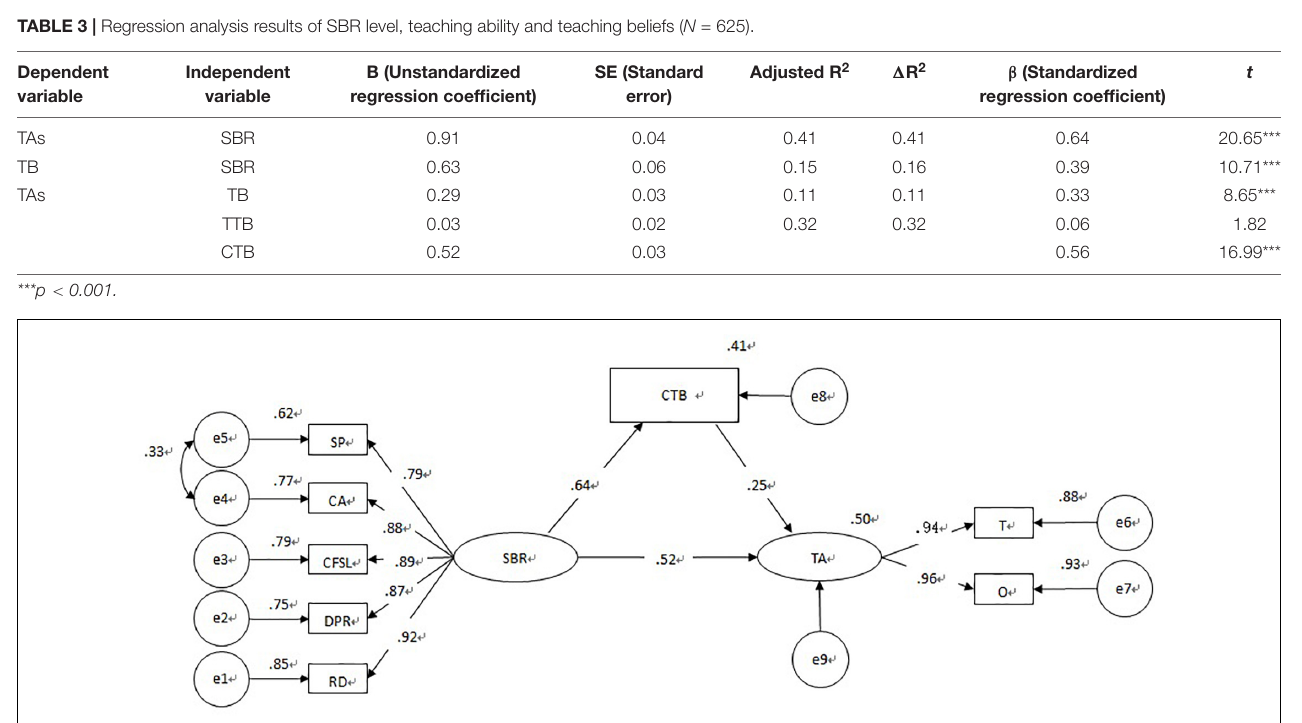
FIGURE 1 | A model diagram of the mediating effect of